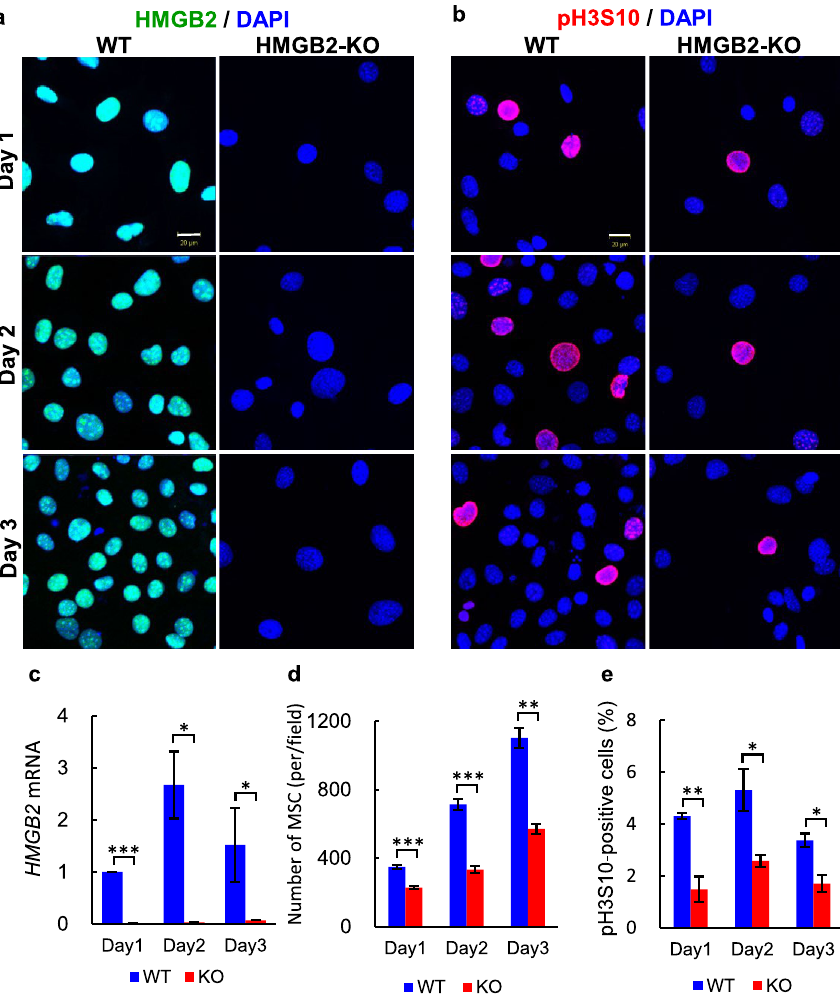
Figure 6. Cell proliferation activity in MSC cells. Immunofluorescence for HMGB2 ( a ) and pH3S10 ( b ) in WT and HMGB2-KO MSCs at 1–3 days post-plating. Nuclei were counterstained with DAPI (blue). Scale bar 20 μm. ( c ) qPCR analysis of HMGB2 mRNA in WT and HMGB2-KO MSCs. ( d ) Number of MSCs per field were counted in WT and HMGB2-KO cells. ( e ) The percentage of pH3S10-positive cells in WT and HMGB2-KO MSCs. Data represent the mean ± SEM from 4 independent experiments. Asterisks indicate statistically significant differences (* p < 0.05, ** p < 0.01, *** p <